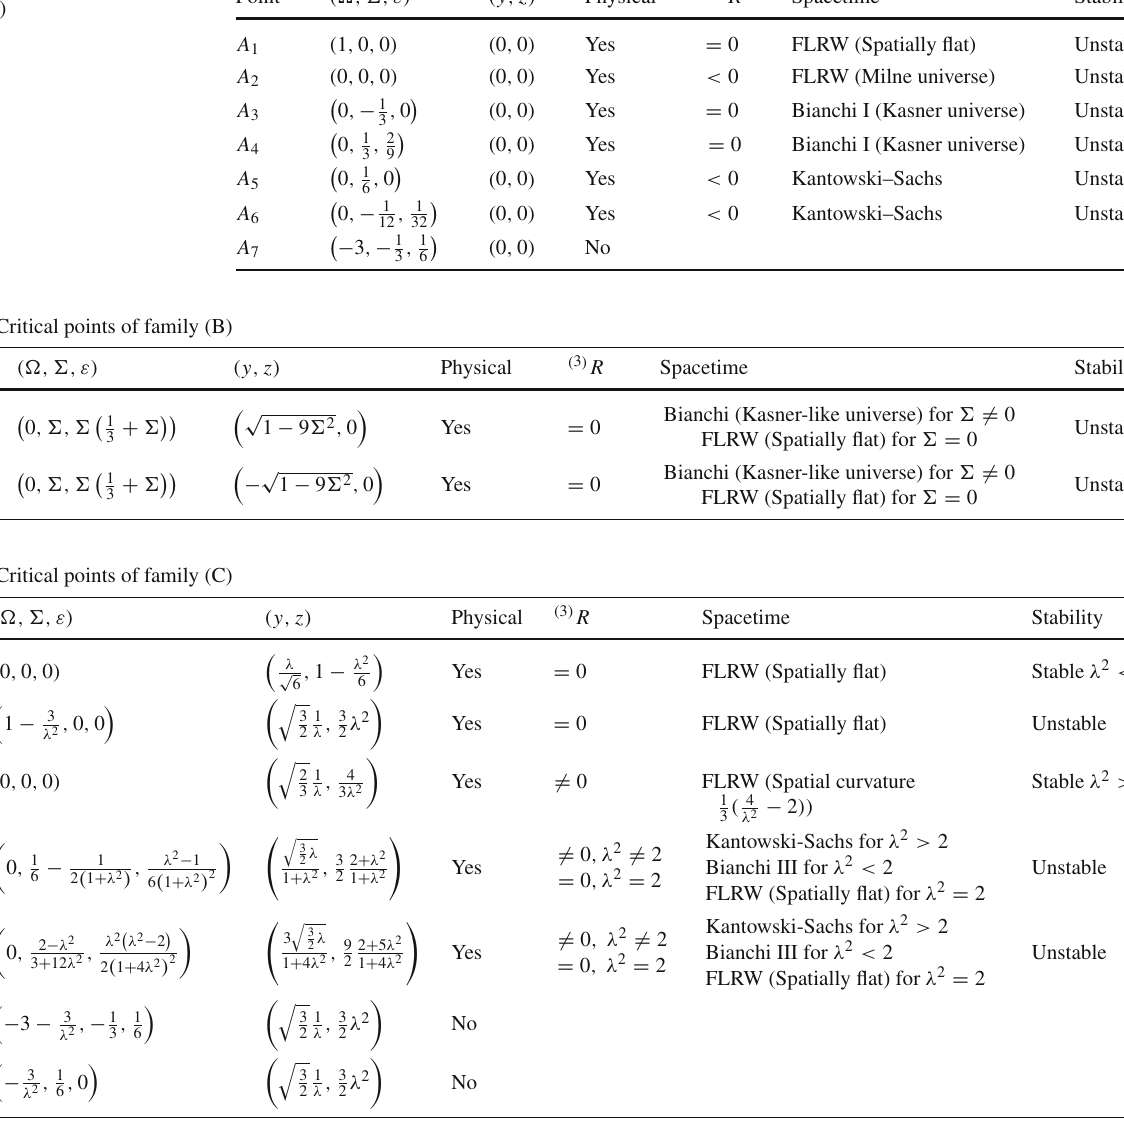
Table 1 Critical points of family (A)